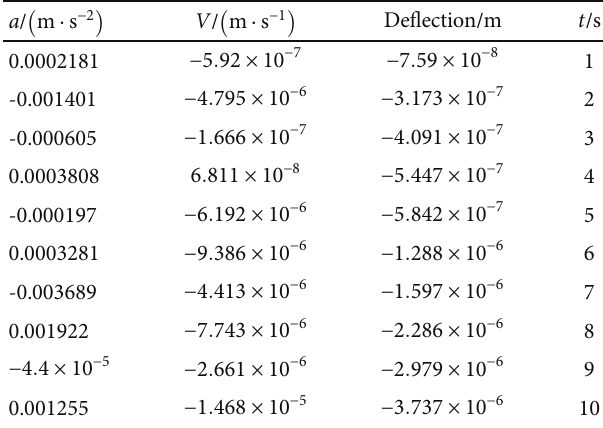
Table 5: Variation of de fl ection (node